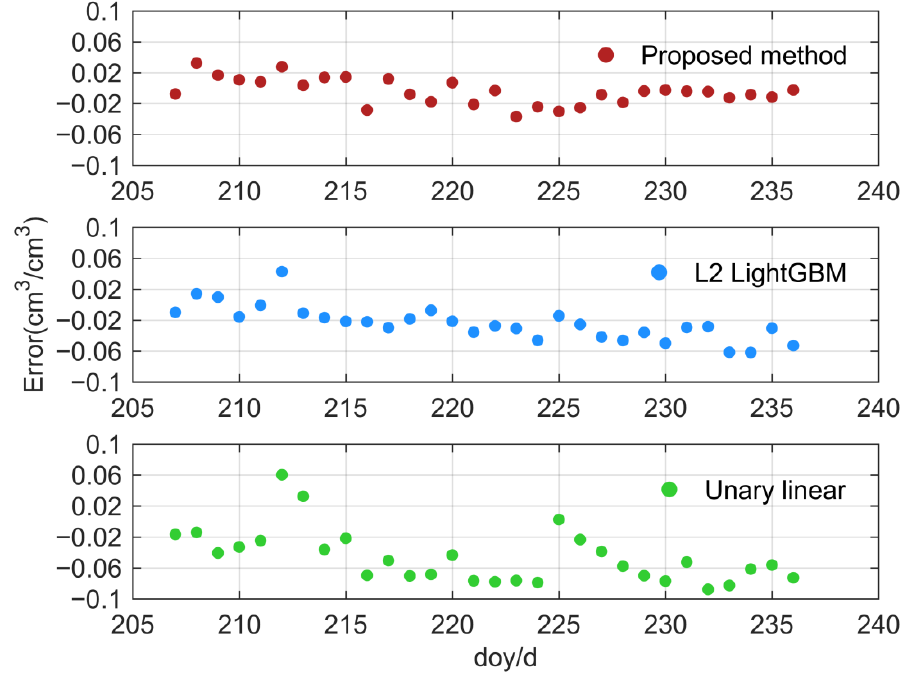
Figure 11. Soil moisture retrieval errors of three methods with station P041.